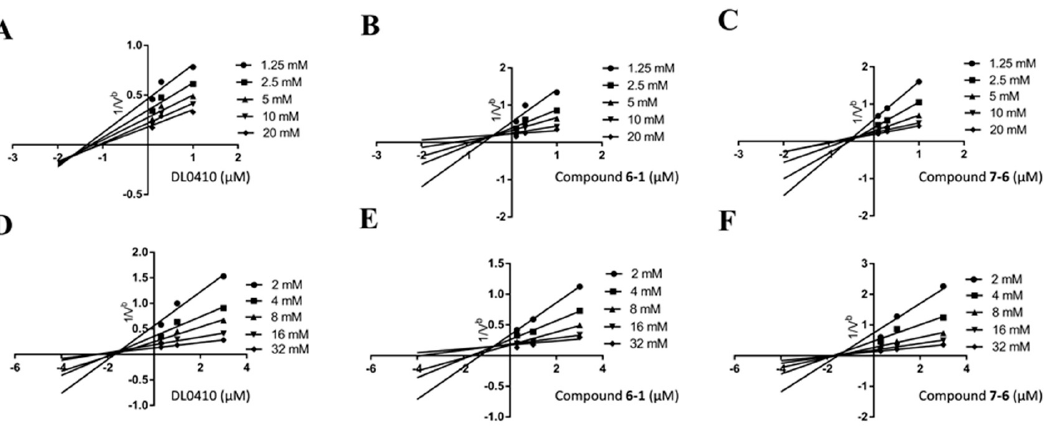
Figure 7. Ki values were determined by Dixon plot. Dixon plots of DL0410, compound 6-1 , and compound 7-6 on AChE inhibitory activity ( A – C ). Dixon plots of DL0410, compound 6-1 , and compound 7-6 on BuChE inhibitory activity ( C – E ). ( n = 3; b = min/ Δ A).